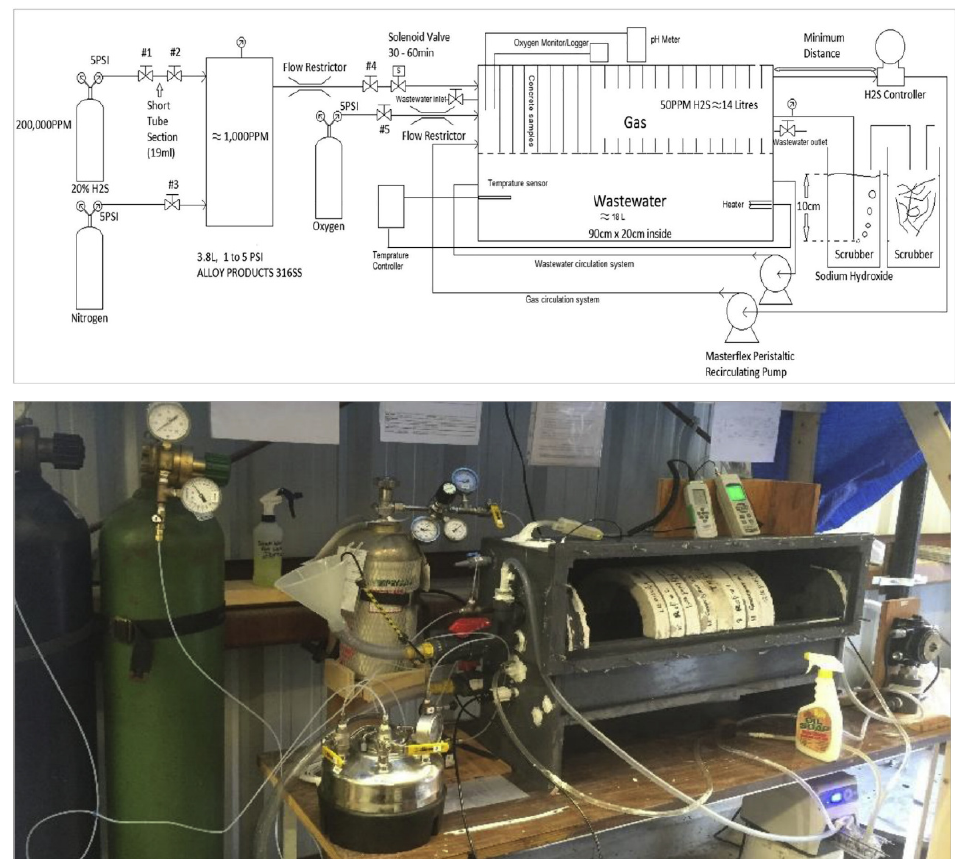
Figure 7. Chamber for simulating concrete biocorrosion